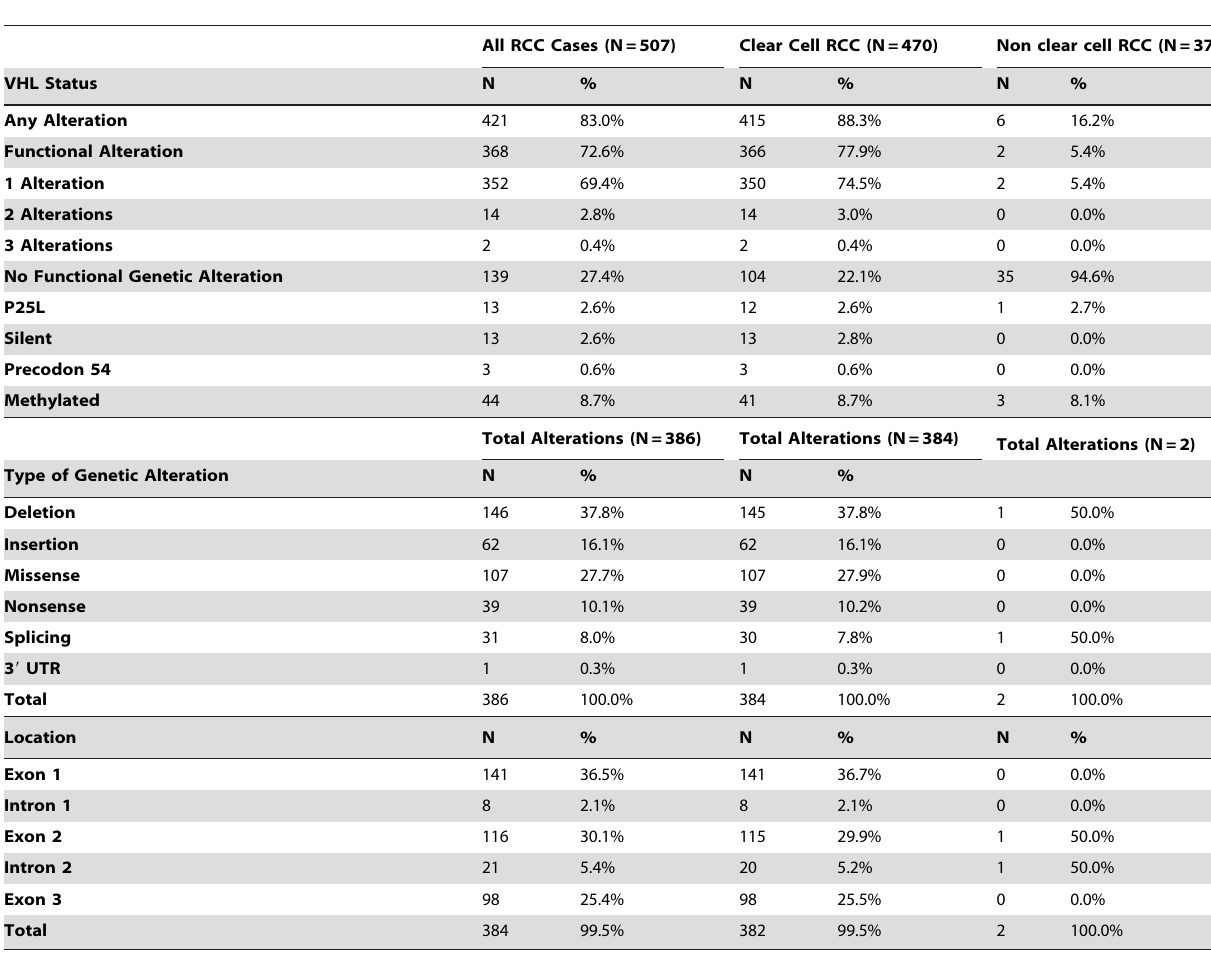
Table 1. VHL gene alterations among histologically confirmed RCC, clear cell RCC, and non-clear cell RCC